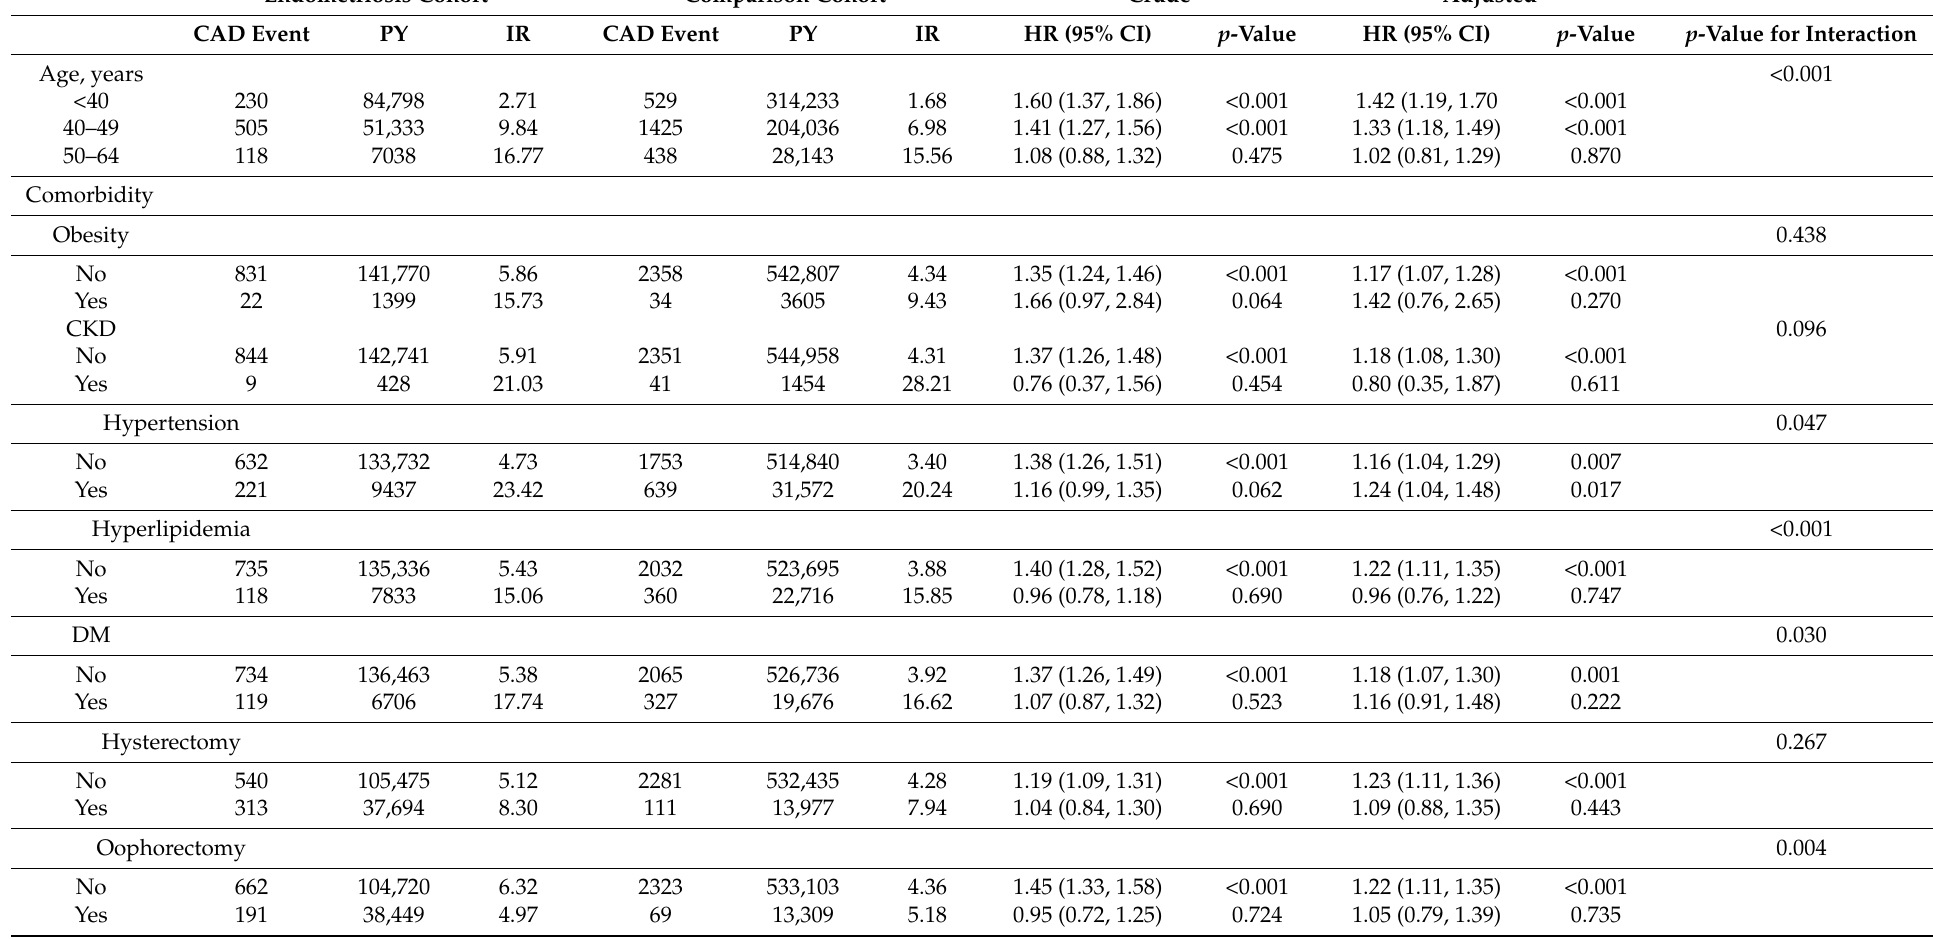
Table 3. Comparison of the incidence rates and hazard ratios of CAD between the two groups stratified by age, comorbidities, and medication. Endometriosis Cohort Comparison Cohort